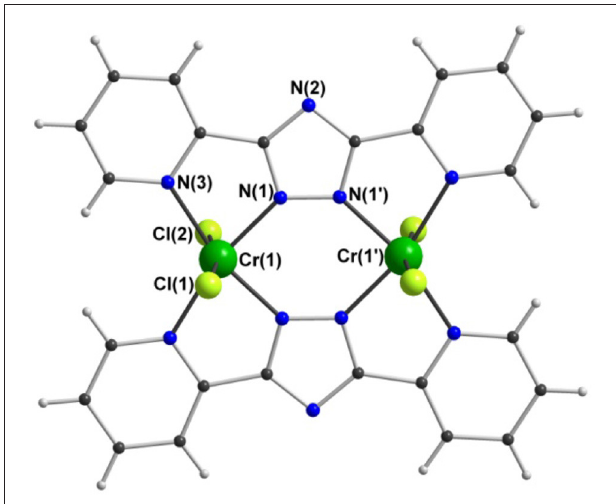
FIGURE 4 | Molecular structure of [Cr III 2 (dpt) 2 Cl 4 ] (2). [V III 2 (dpt) 2 Cl 4 ] (1) is